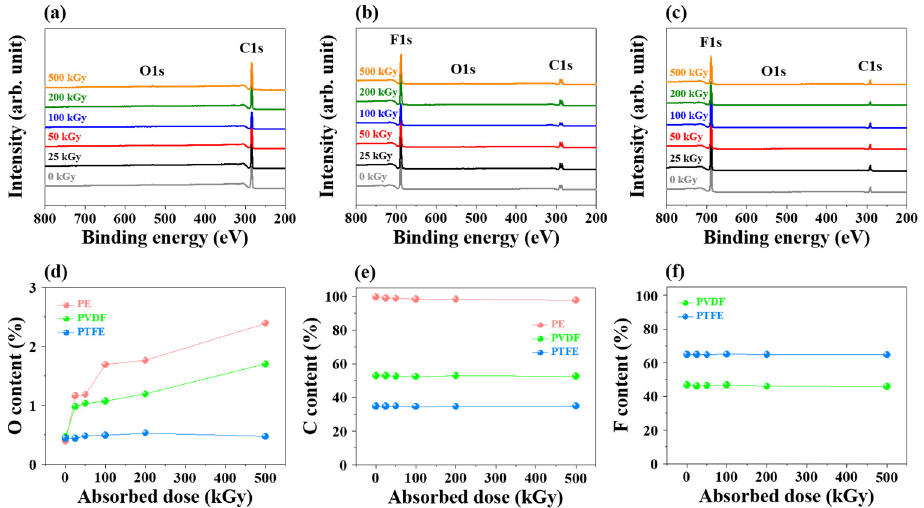
Figure 2. XPS survey spectra of ( a ) PE, ( b ) PVDF, and ( c ) PTFE; Changes in the atomic percentages of ( d ) oxygen, ( e ) carbon, and ( f ) fluorine.